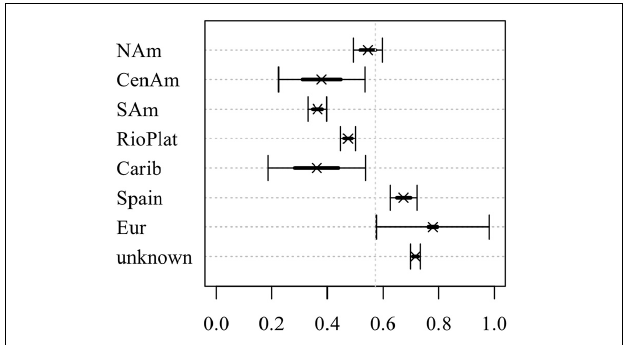
FIGURE 1 | Predicted probabilities of dative clitic from Miglio et al. (2013: